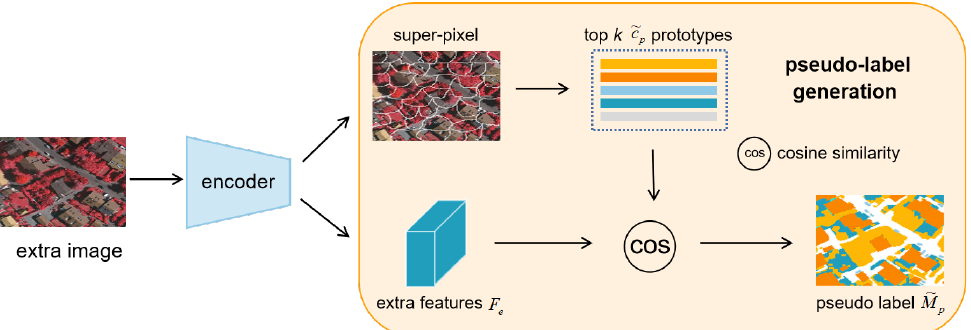
Figure 2. Detail diagram of pseudo-label generation